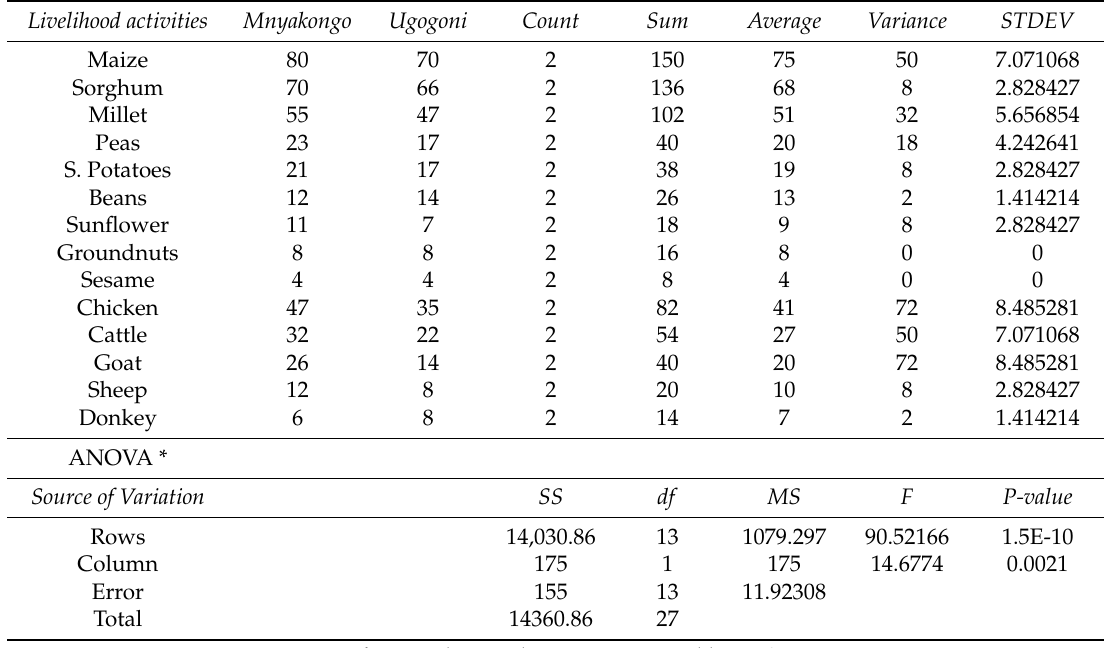
* Anova: Two-factor without replication. Source: Field Data Survey,